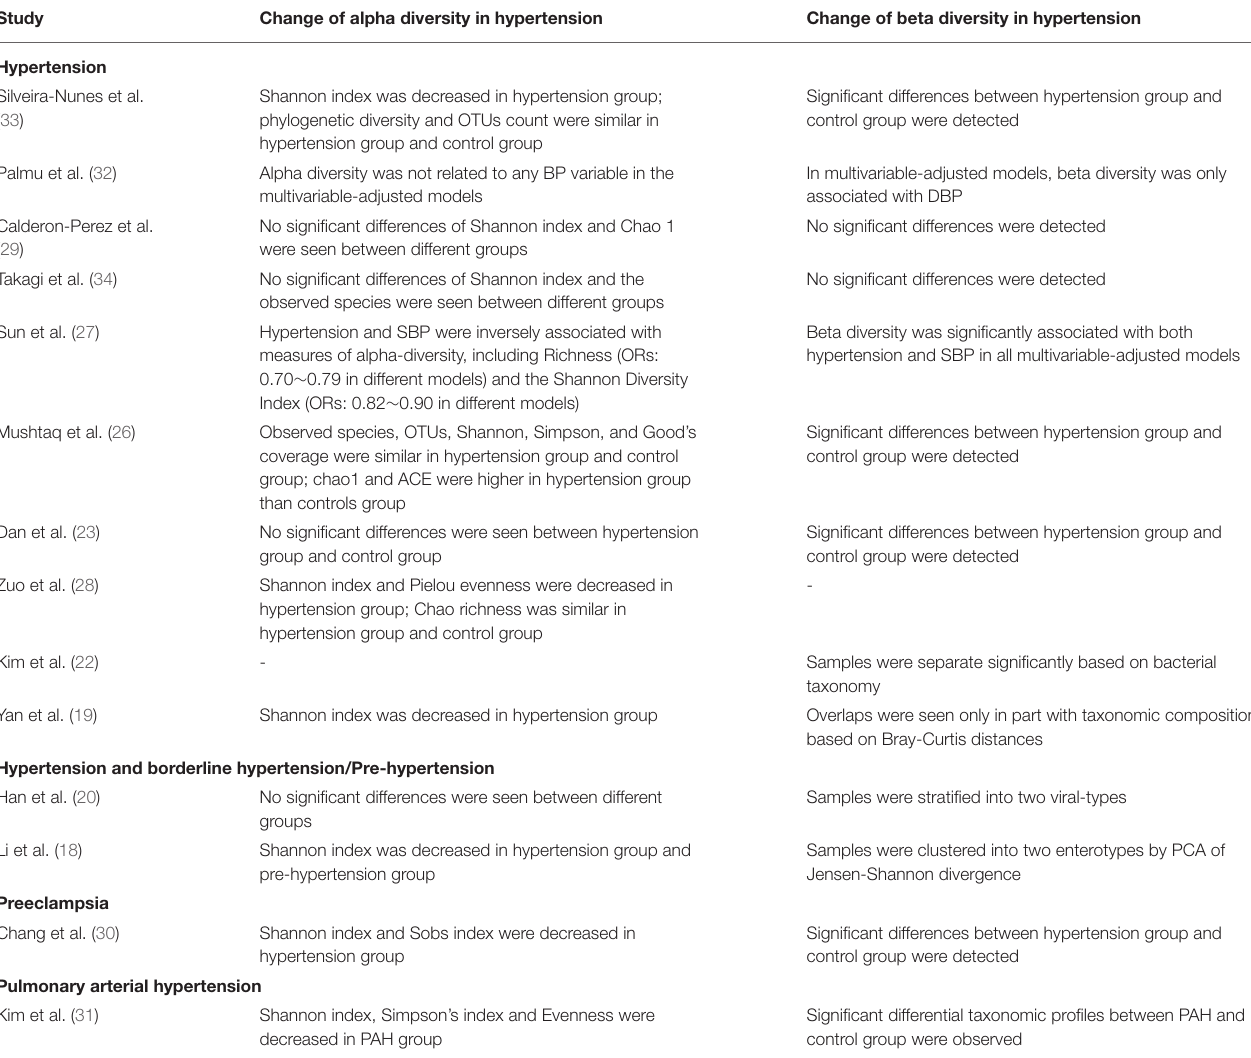
TABLE 2 | Major findings of the included studies on diversity.